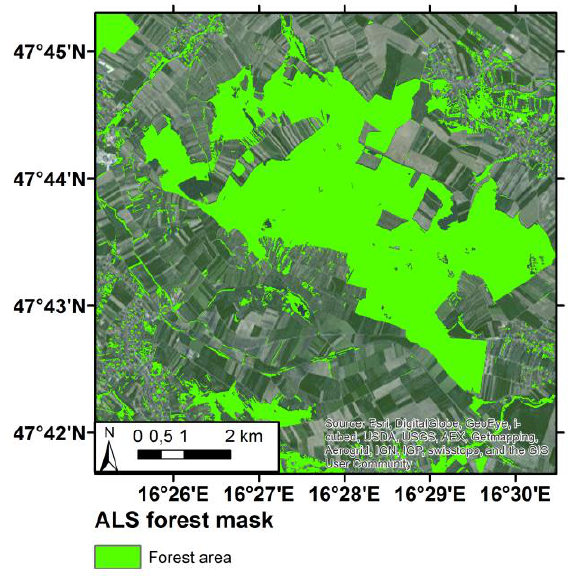
Figure 2: Subset of the derived forest mask with a minimum mapping unit of 500 m², crown coverage ≥30%, minimum height 3 m and minimum width of 10 m. In the background an ArcGIS Online basemap orthophoto is